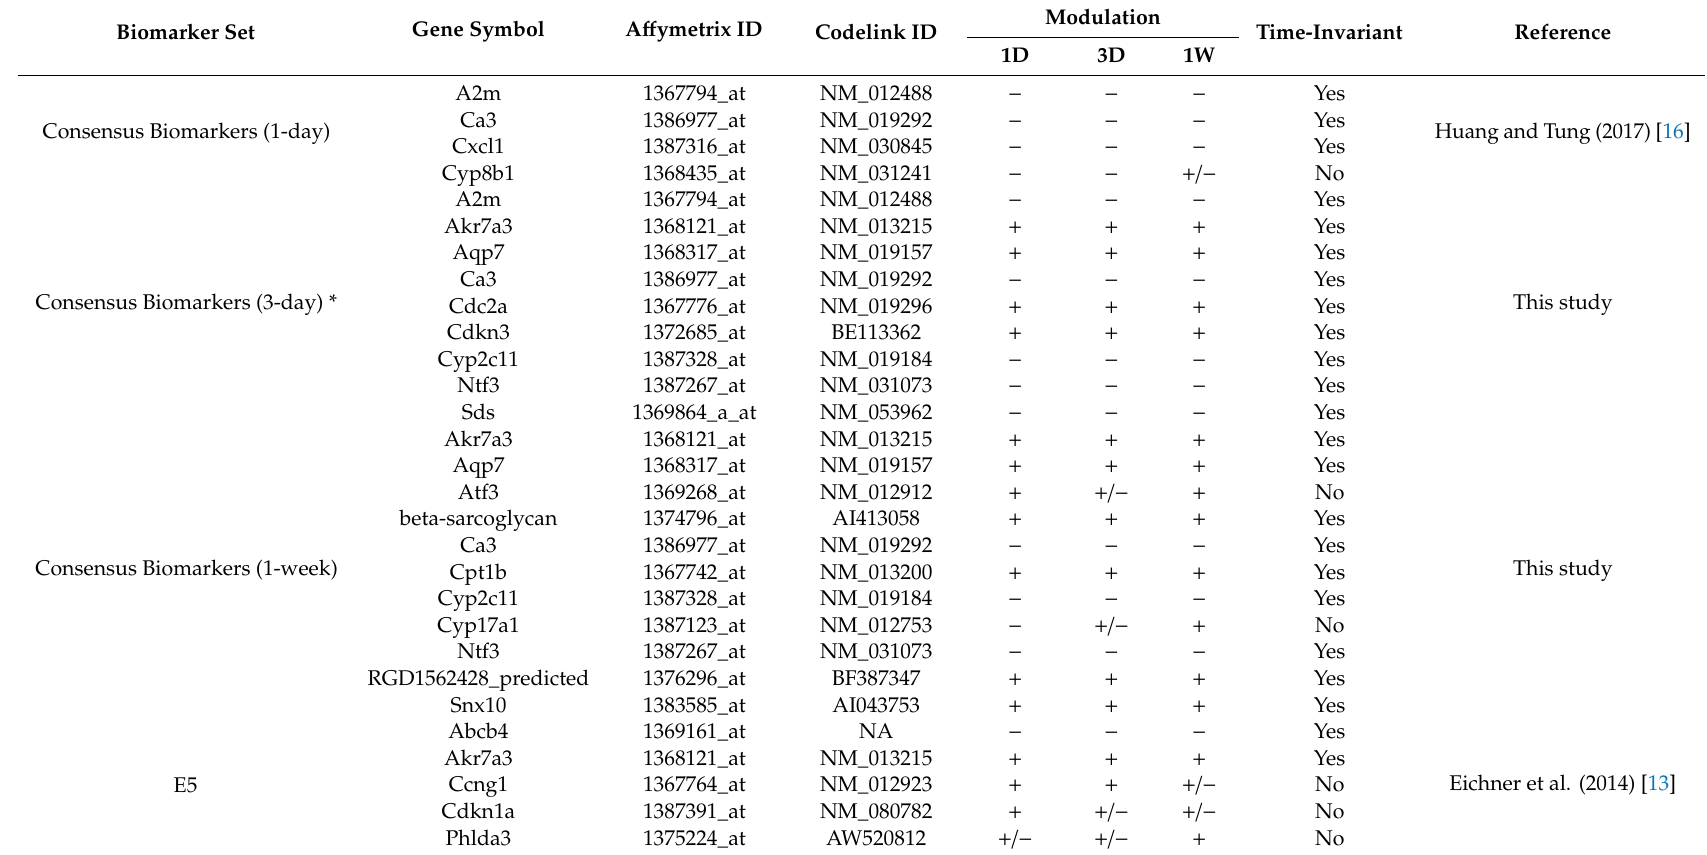
Table 1. Biomarkers and corresponding modulations for three short-term exposure